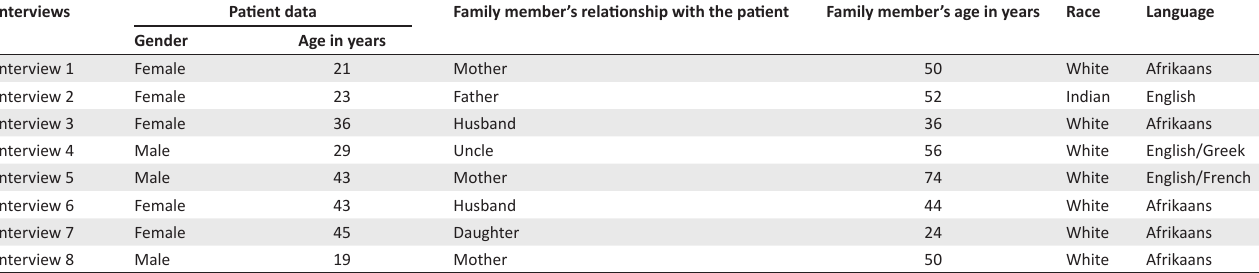
TABLE 1: Demographic data of family members as participants.